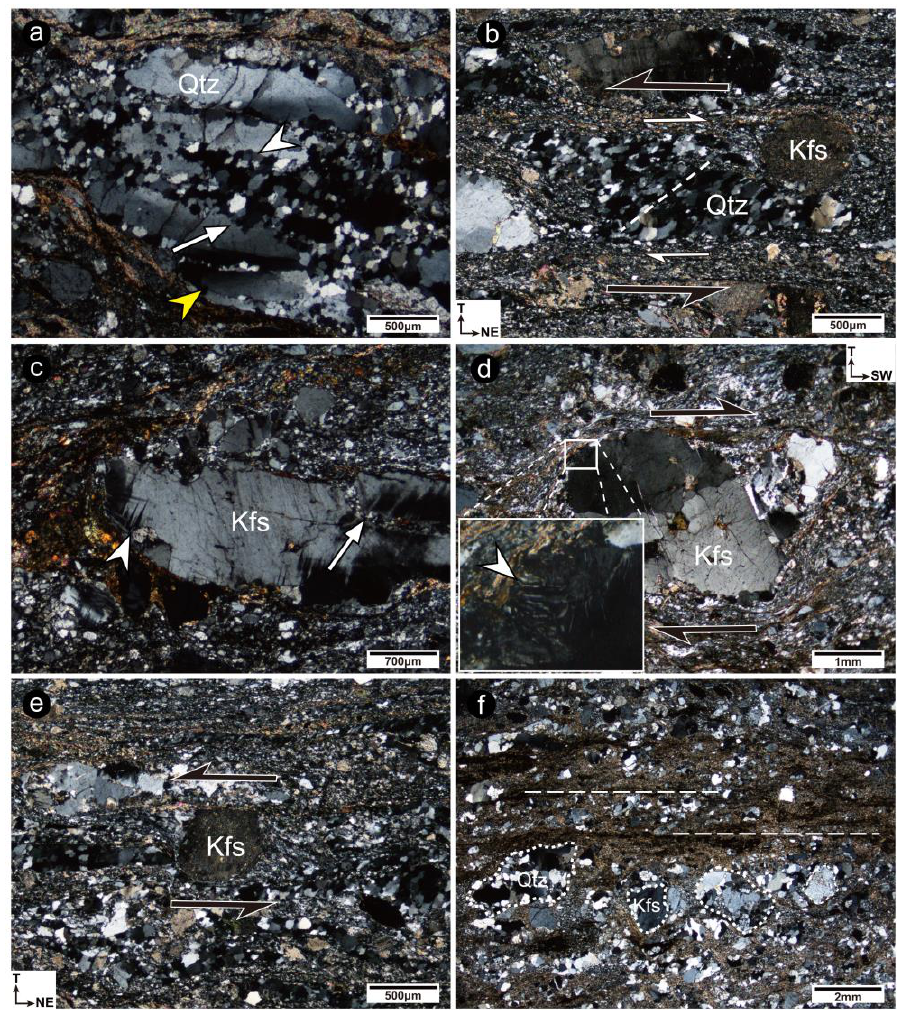
Figure 8. Photomicrograph (cross-polarized light) showing microstructures of the Soya Shear Zone (SSZ). ( a ) Recrystallized quartz grains through bulging (long arrow) and subgrain rotation (arrow), and undulatory extinction in original quartz grain (yellow arrow). ( b ) Asymmetric quartz lens indicating a top-up-to-the-southwest sense of shear. Relict of steady-state foliation in the quartz lens (dashed line) implies an opposite shear sense. ( c ) Deformation twin (arrow) and intragranular fractures (long arrow) filled with quartz and white mica in feldspar. ( d ) Asymmetric occurrence of strain-related myrmekite in feldspar, indicating a top-up-to-the-southwest sense of movement. ( e ) σ -type strain shadow indicating a top-up-to-the-southwest sense of shear. ( f ) Foliated cataclasite along the lower boundary of the SSZ. Abbreviations: Qtz—Quartz, Kfs—K-feldspar.